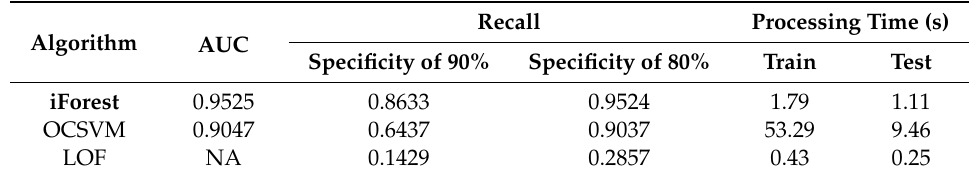
Table 6. AUC, recall and processing